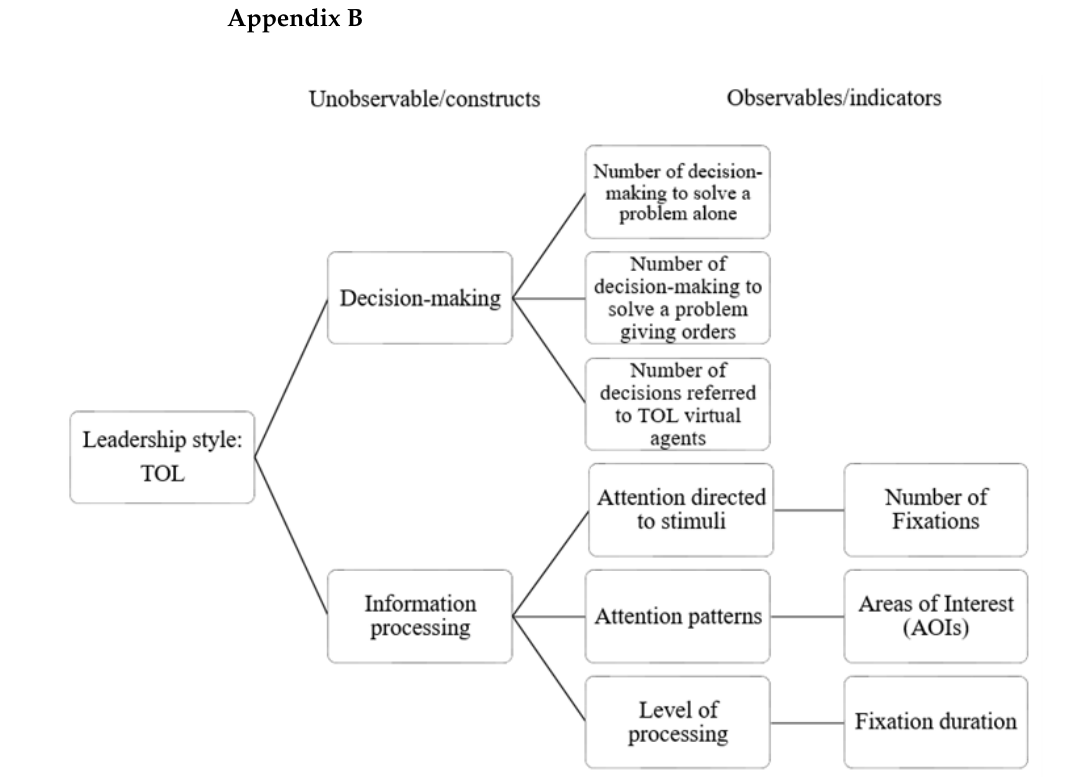
Figure A11. TOL competency model.